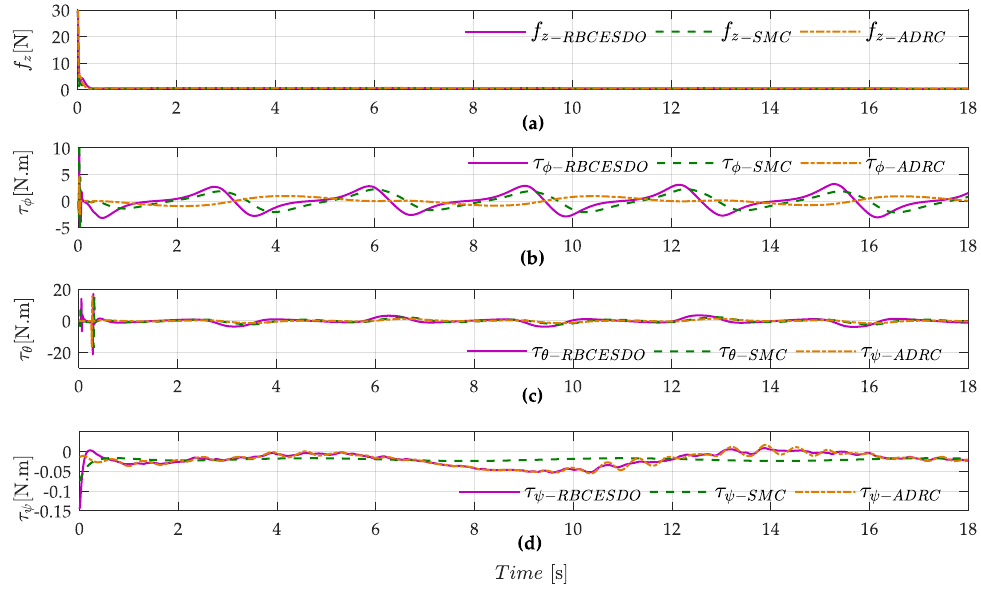
Figure 7 . Comparison of the controller performance between RBCESDO, SMC, and ADRC: vertical force ( a ), roll torque ( b ), pitch torque ( c ) and yaw torque ( d ).